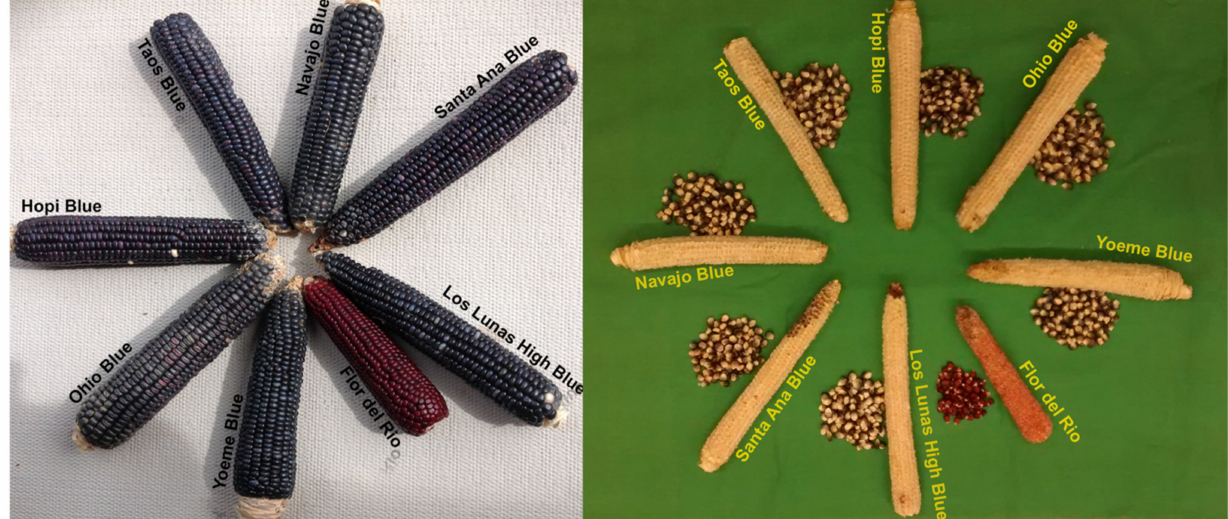
Figure 11. Representative ears (unshelled-on left ) and kernels with cobs (shelled-on right ) of blue corn landraces. All landraces are labeled and are of Southwestern US origin except Midwestern Corn Belt Ohio